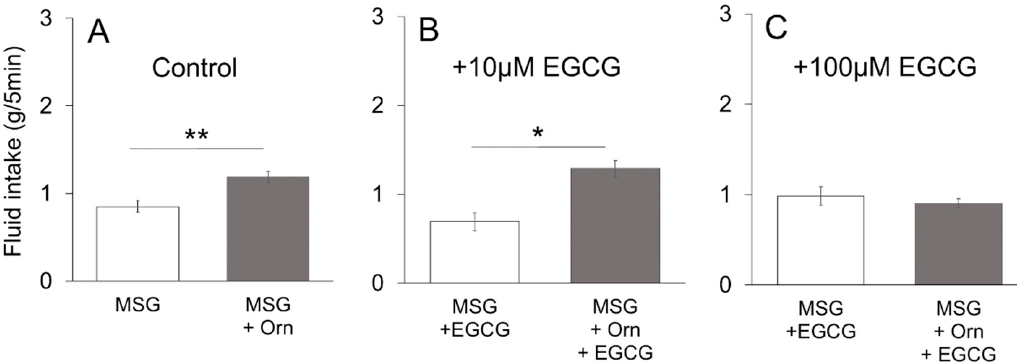
Figure 5. Effects of GPRC6A antagonists on the amount of intake of 0.05 M MSG with and without 1 mM L-ornithine (Orn). Each of the antagonists, (A) NPS-2143, (B) Calindol and (C) EGCG, dose-dependently suppressed. Each of the an- tagonists (NPS-2143, calindol and EGCG) dose-dependently suppressed Orn-induced preference. Each value is mean ± SE; n = 8. *** p < 0.001.